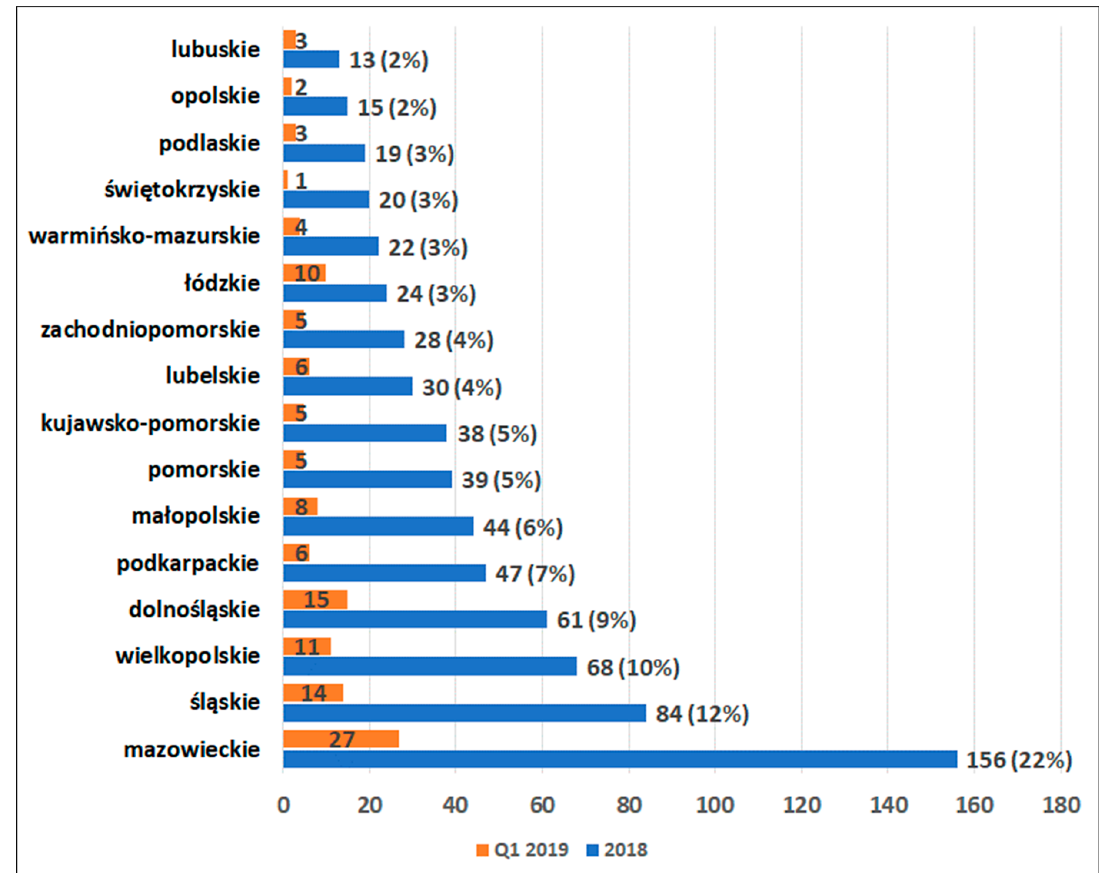
Figure 1. Number of bankruptcies in Polish voivodeships in Q1 2019 and in 2018. Source: own elaboration based on the data analyzed from Coface Nationwide Bankruptcy Monitor (http://www.emis.com).